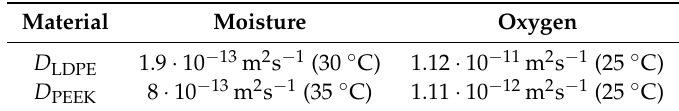
Table 3. Diffusion constants of moisture and oxygen in LDPE and PEEK